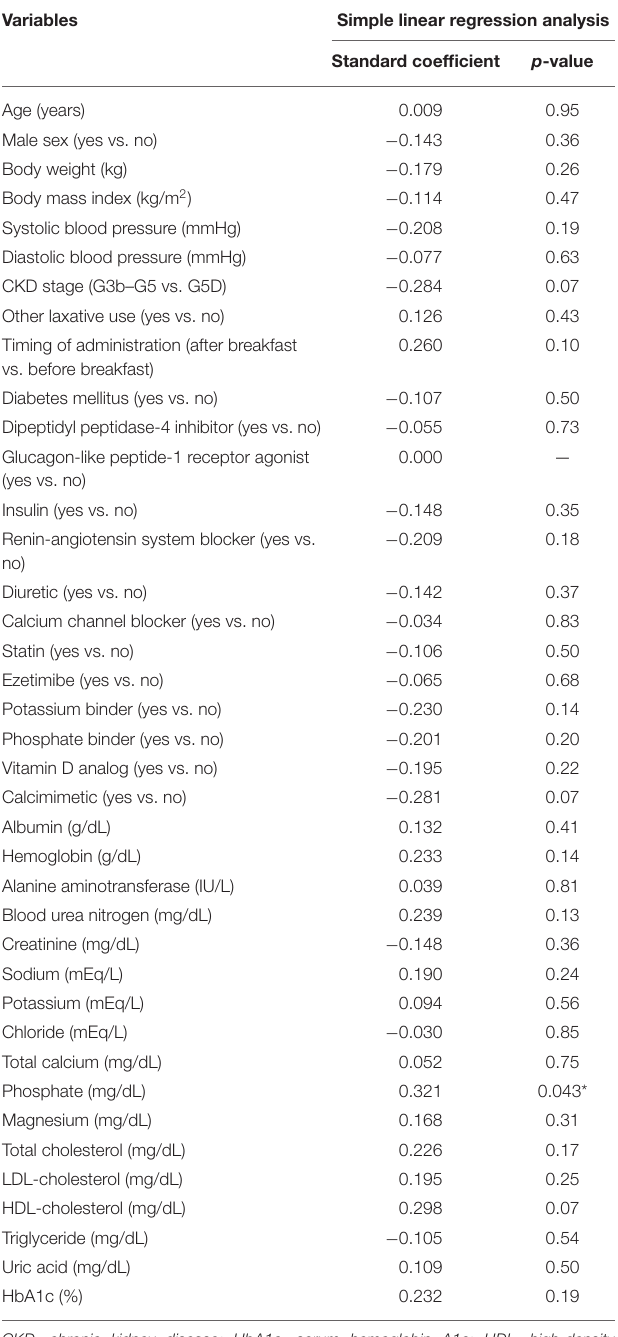
TABLE 4 | Simple linear regression analyses of the variables correlated with the change in stool frequency after initiation of elobixibat administration. Variables Simple linear regression